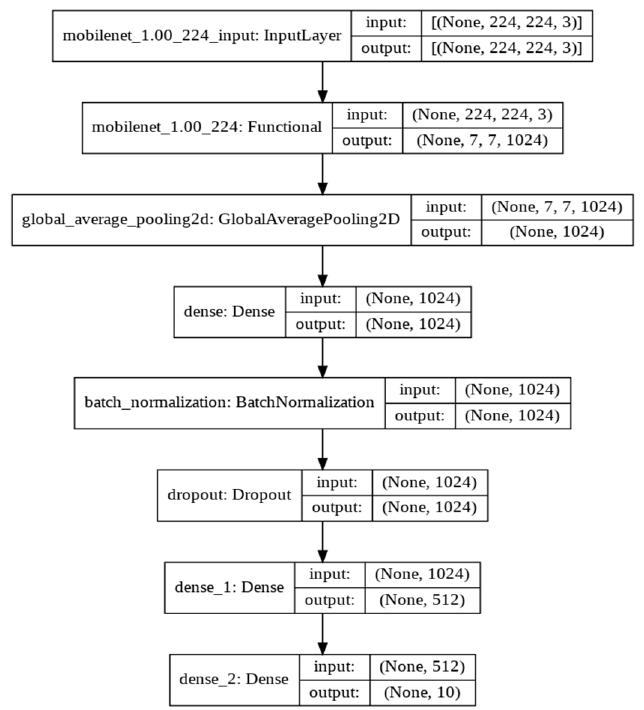
Figure 9. Model Architecture (MobileNet).